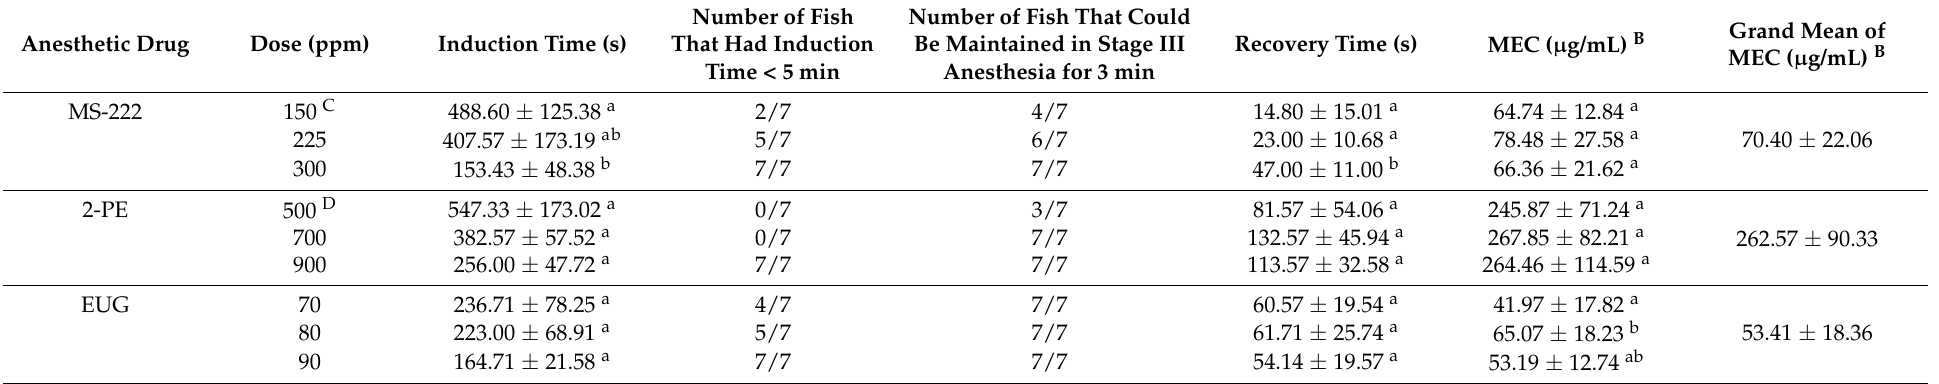
Table 1. The induction time, recovery time, and minimum effective concentration (MEC) of tricaine methanesulfonate (MS-222), 2-phenoxyethanol (2-PE), and eugenol (EUG) in Nile tilapia at 28 ◦ C following single immersion administrations ( n = 7) A